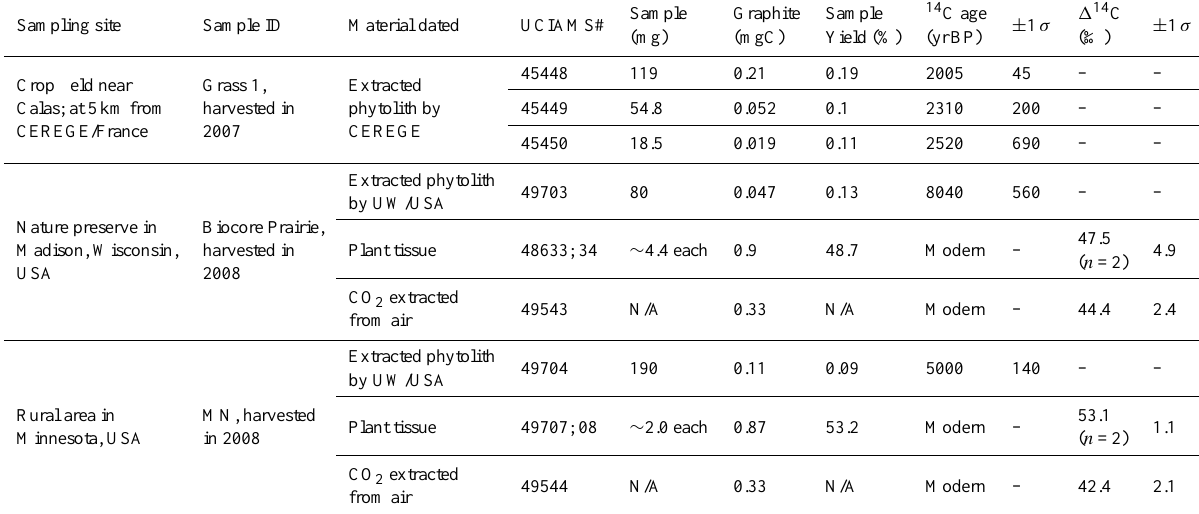
Table 2. Radiocarbon results shown are from harvested grasses phytolith concentrates, bulk grass tissue and atmospheric CO 2 extracted from air cans collected in the rural areas from which the grasses were collected. Phytolith extractions were performed by two laboratories (CEREGE, France and UW, USA), following the Kelly et al. (1991) phytolith extraction protocol for plant tissue, as described in Santos et al. (2010a). Radiocarbon results and associated uncertainties were calculated using procedural blanks from SiO 2 (to mimic opal phytolith) subjected to the same chemical phytolith extraction as that used for plants. Table adapted from Santos et al.